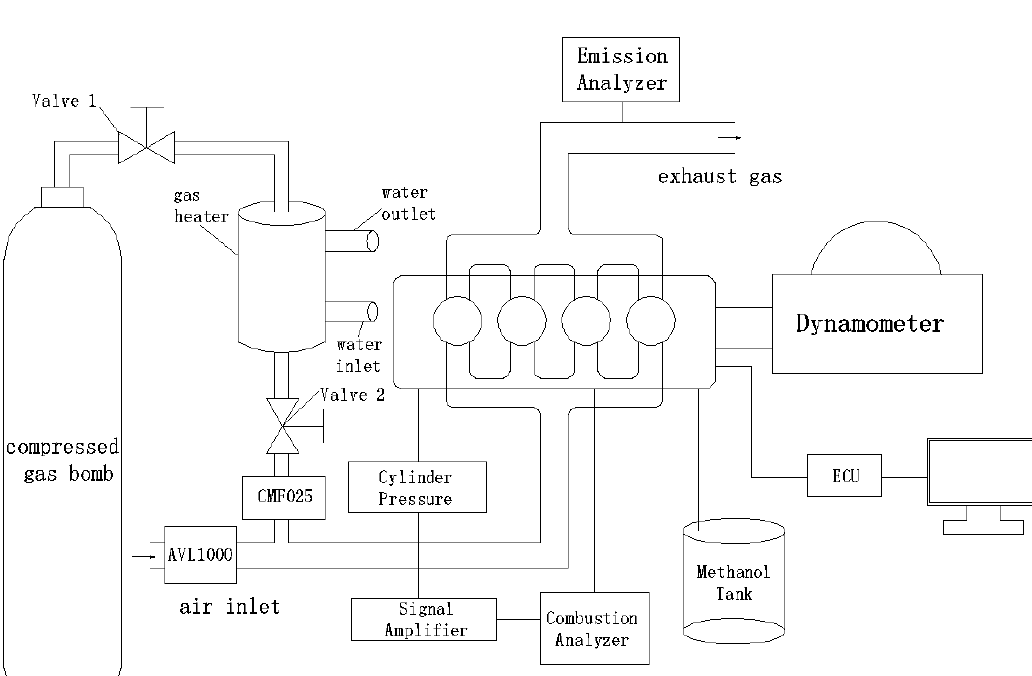
Figure 1. Schematic diagram of the experimental setup.